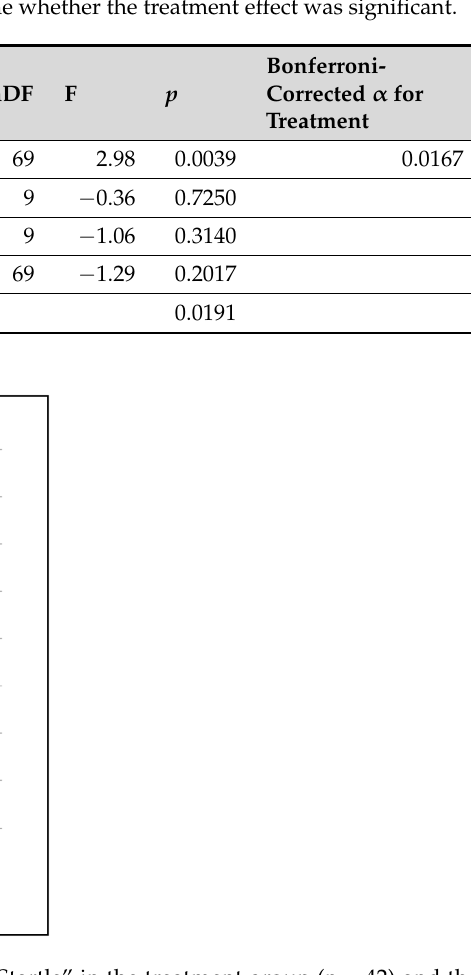
Figure 1. Mean values ± SEM for “ PC 1 — Social-Startle ” in the treatment group (n = 42) and the control group (n = 41). Table 8. Results of the linear mixed-effects model assessing the effect of treatment, age, litter size, and sex on “ PC 1 — Social-Startle ” . The p -value for litter refers to the ANOVA comparing the models with and without litter included. “ Bonferroni- corrected α for treatment ” indicates the alpha level (after sequential Bonferroni correction) to determine whether the treatment effect was significant.